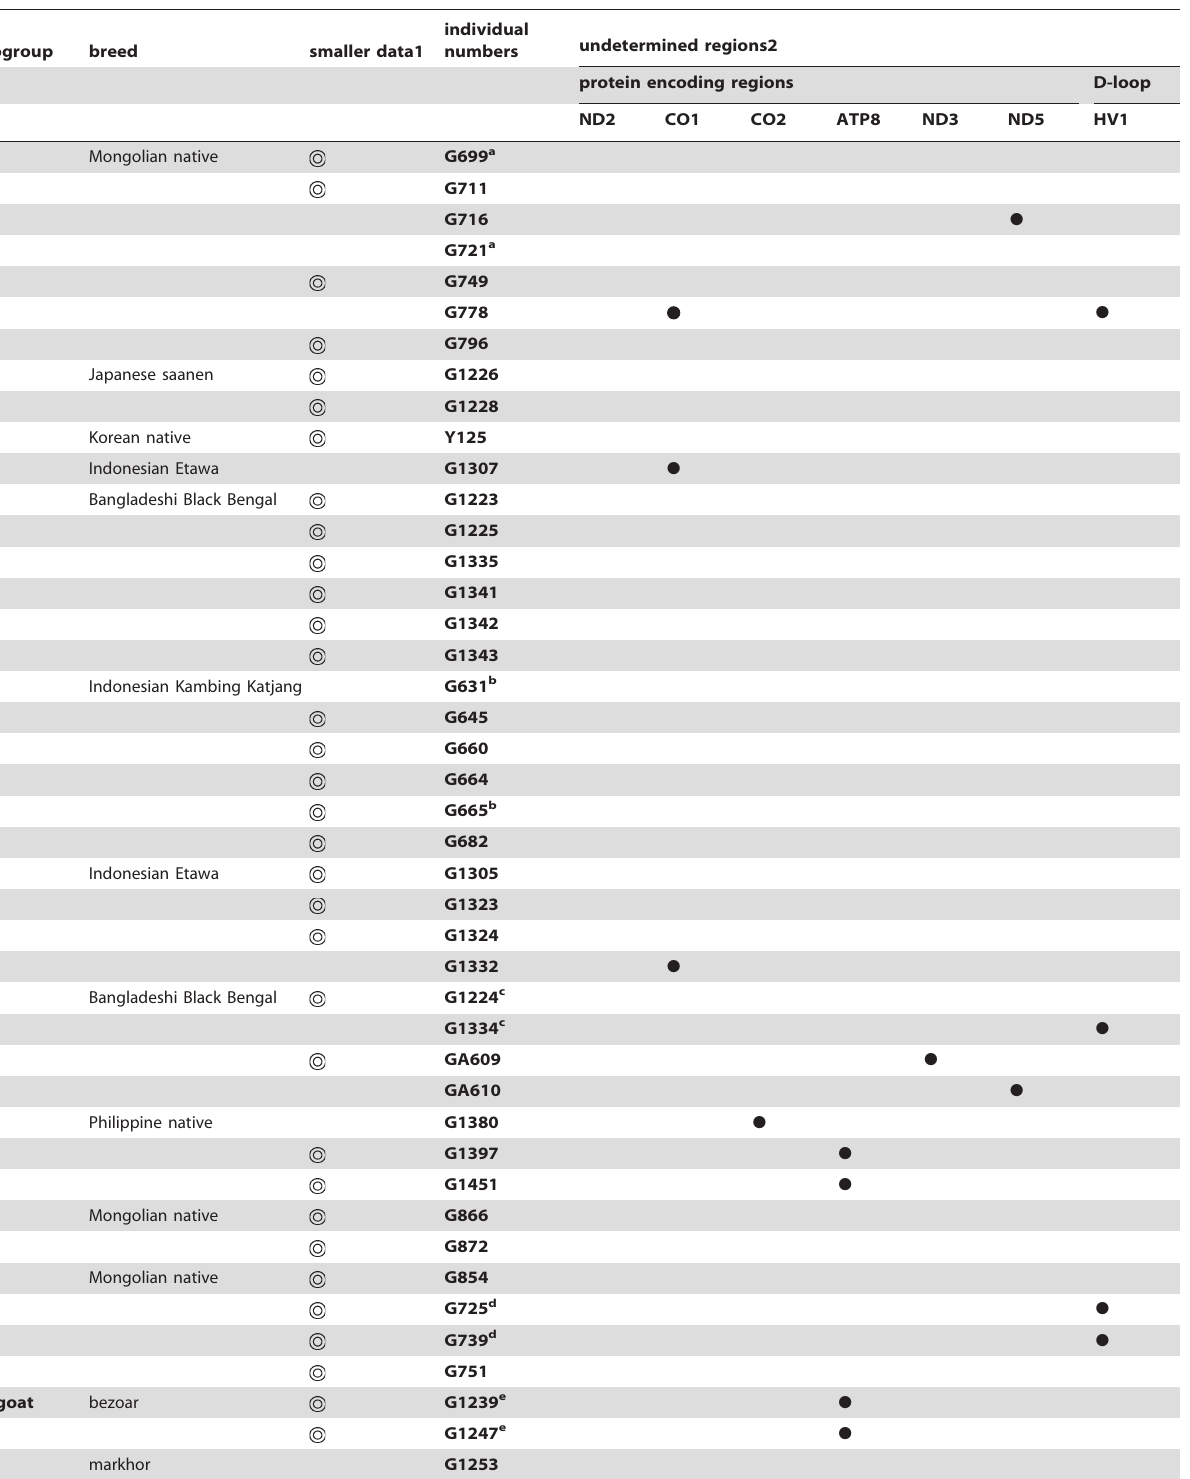
Table 1. Summary of sample information for the present study.